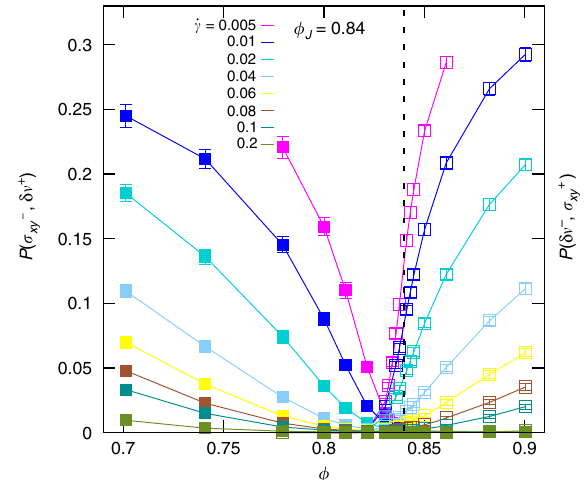
; δ v þ Þ Fig. 2 Mutually exclusive fl uctuations. Joint probabilities P ð σ (cid:3) xy Þ (right axis, hollow symbols) as (left axis, fi lled symbols) and P ð δ v (cid:3) ; σ þ xy functions of packing fraction, ϕ , for various shear rates, _ γ . In the fl uid state, ϕ < ϕ J , the dominant mechanism of negative power injection is the reversal of the shear stress. In the jammed state, ϕ > ϕ J , it is due to the reversion of the velocity gradient. Error bars correspond to square root of variance